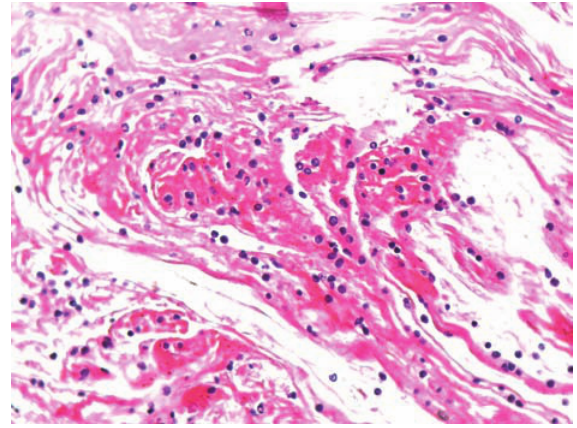
Figure 3 - Transbronchial biopsy (Hematoxylin-Eosin × 100): preserved alveolar walls without fibrosis or significant inflammation having only a few alveolar macrophages. No histological evidence of chronic lung disease, granulomas or